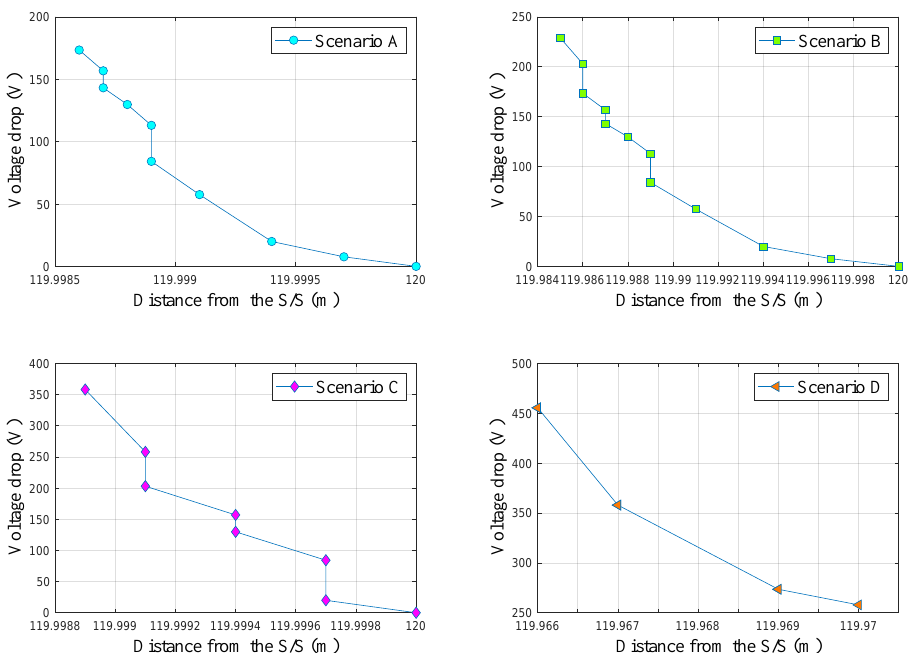
Figure 7. Stress drop in study scenarios.